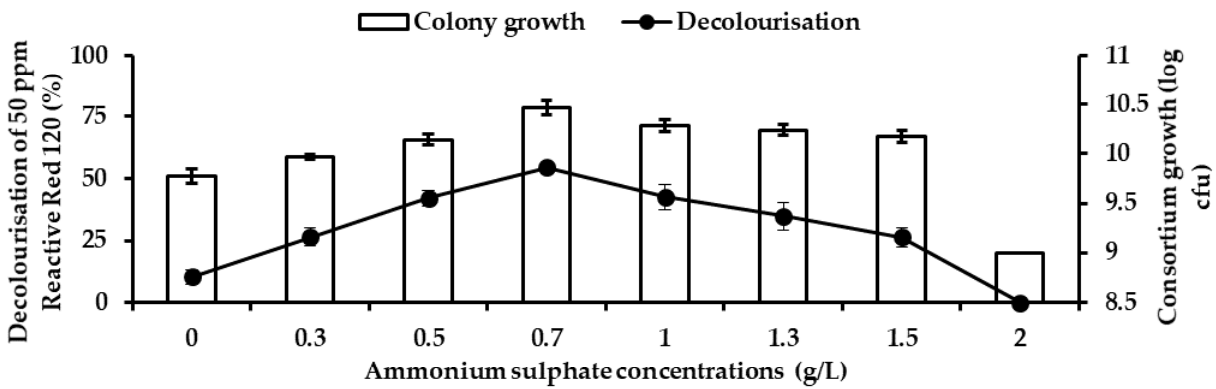
Figure 10. Effects of different ammonium sulphate concentration on the decolourisation of 50 ppm Reactive Red 120 by consortium JR3. Data represent mean ± SD, n = 3.